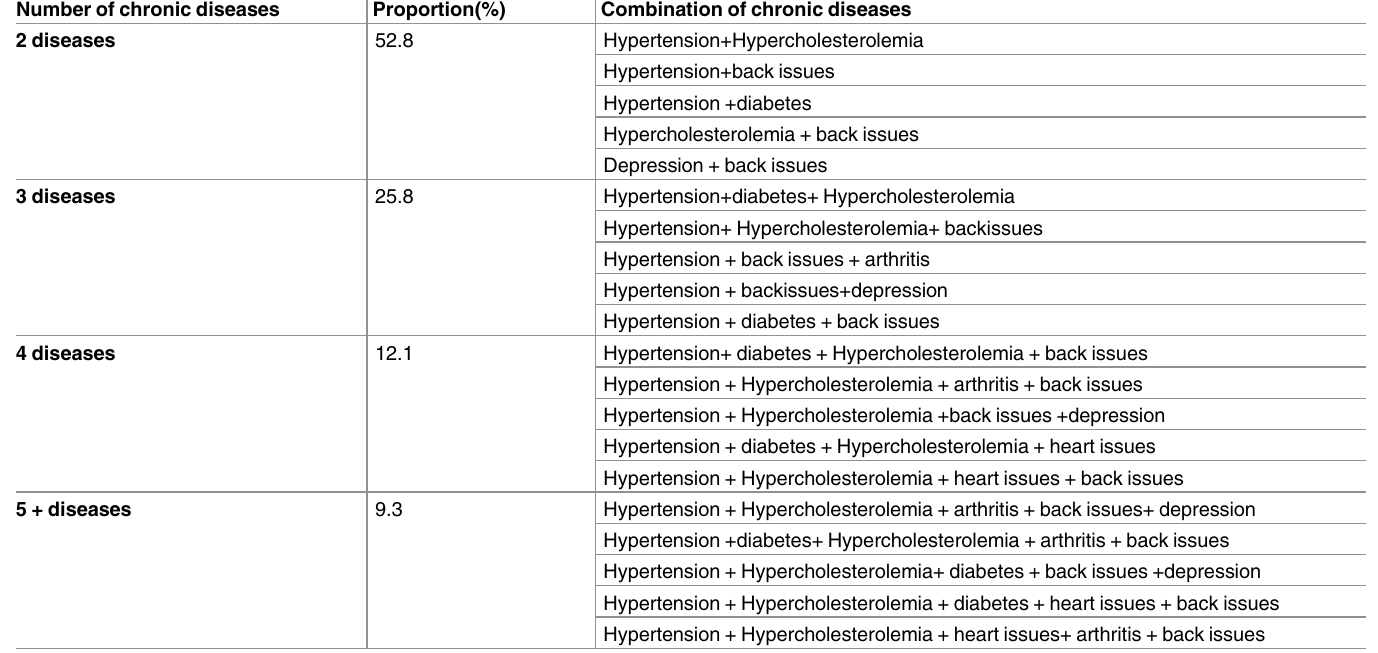
Table 3. Combination of chronic diseasesamong respondents with multimorbidity. NHS, Brazil, 2013. Number of chronic